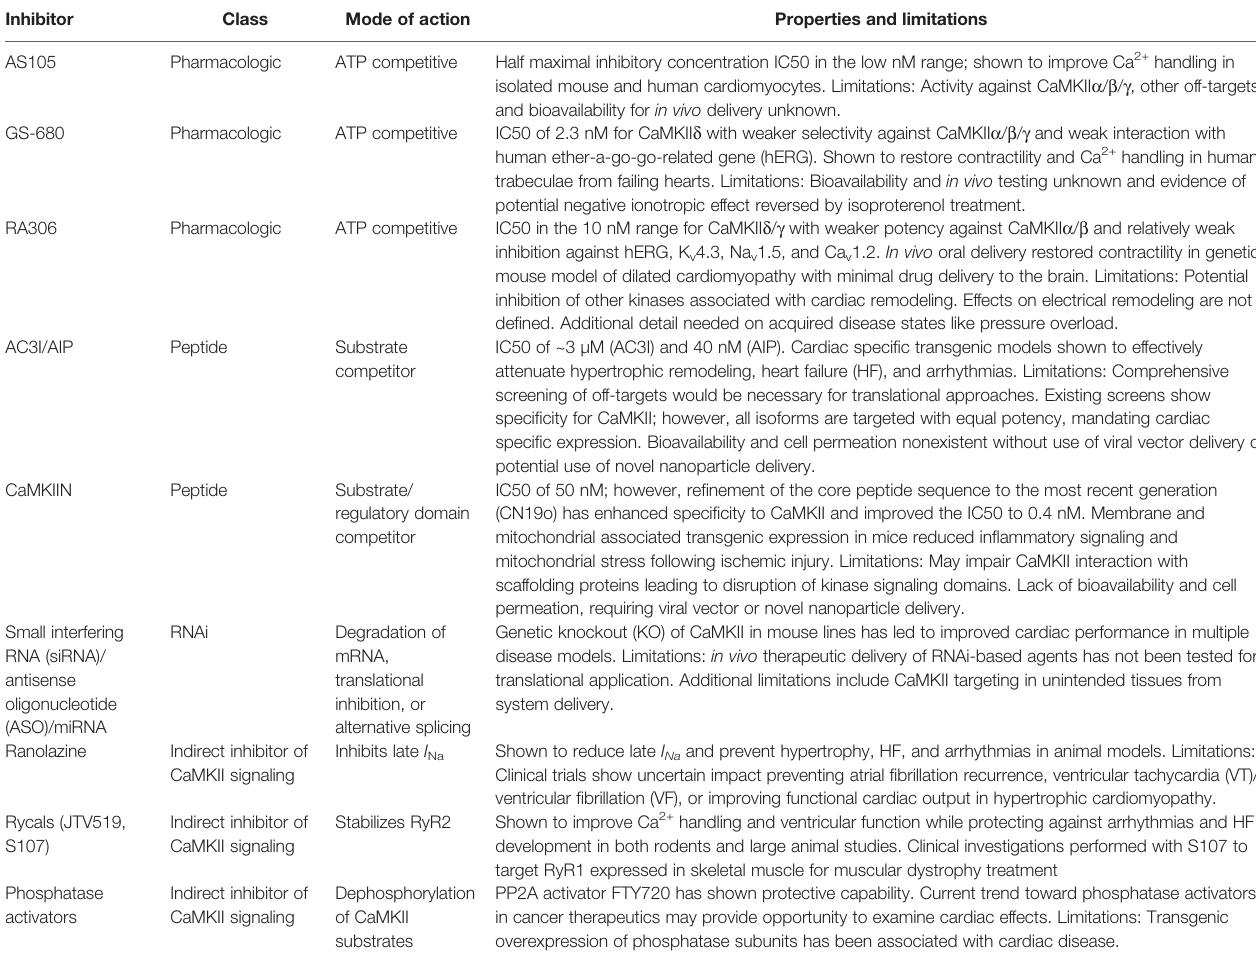
TABLE 1 | Properties and limitations of Ca 2+ /calmodulin-dependent protein kinase II (CaMKII) inhibitory